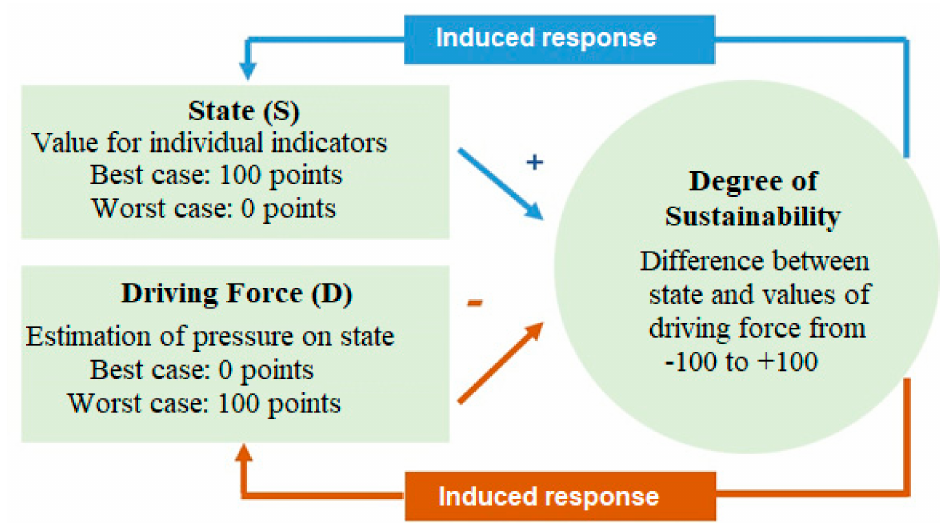
Figure 2. Methodology for calculating the degree of sustainability according to the RISE